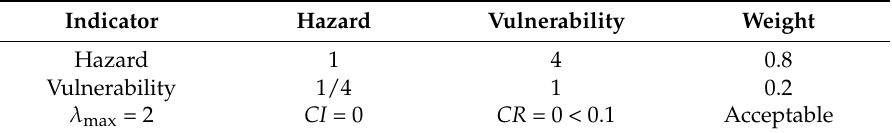
Table 4. Matrix construction and weight calculation of indices in intermediate